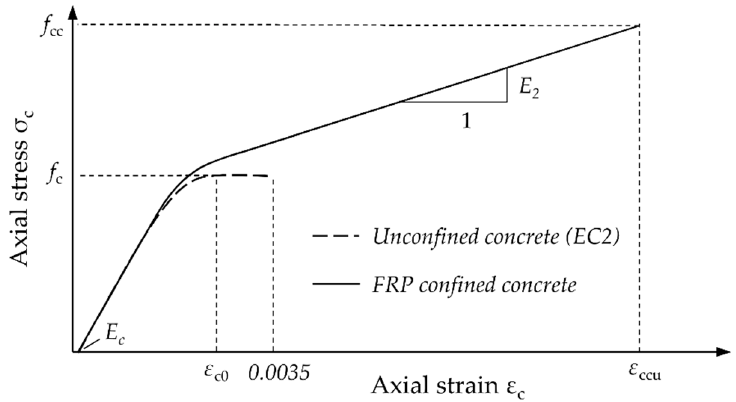
Figure 1. Stress-strain model for FRP confined concrete according to Lam and Teng [15].